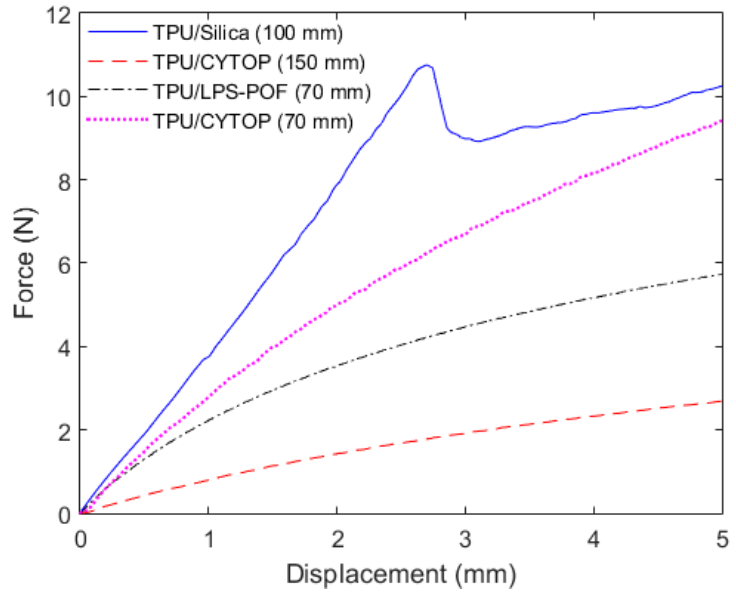
Figure 4. Force-displacement curves for each material combination with different lengths.